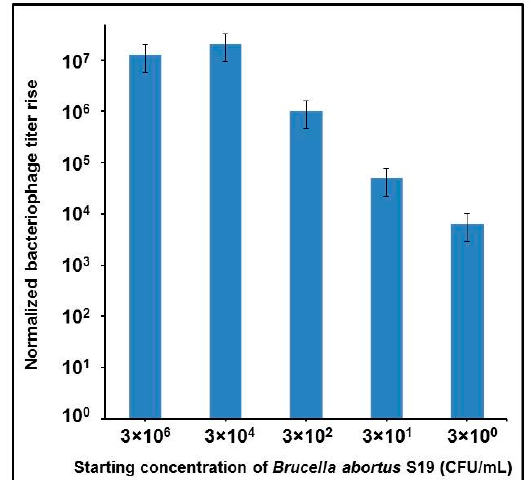
Figure 5. Amplification of the Bk phage after 72 h growth on different concentrations of B . abortus